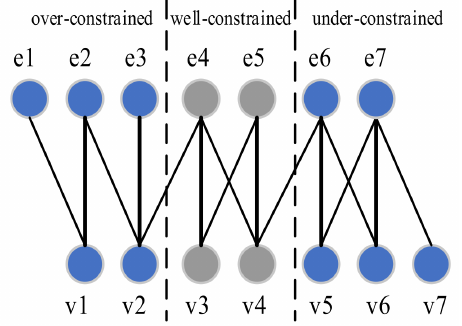
Figure 2. Decomposition of the bipartite graph representation of the equations in Equation